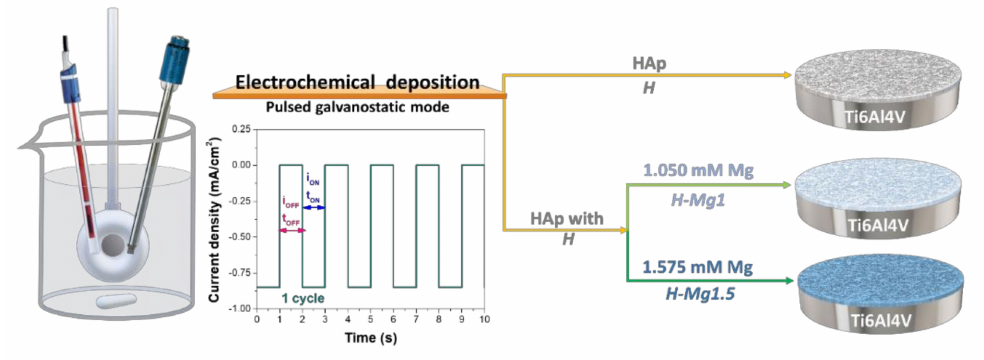
Figure 1. Schematic illustration of the electrochemical deposition process and samples